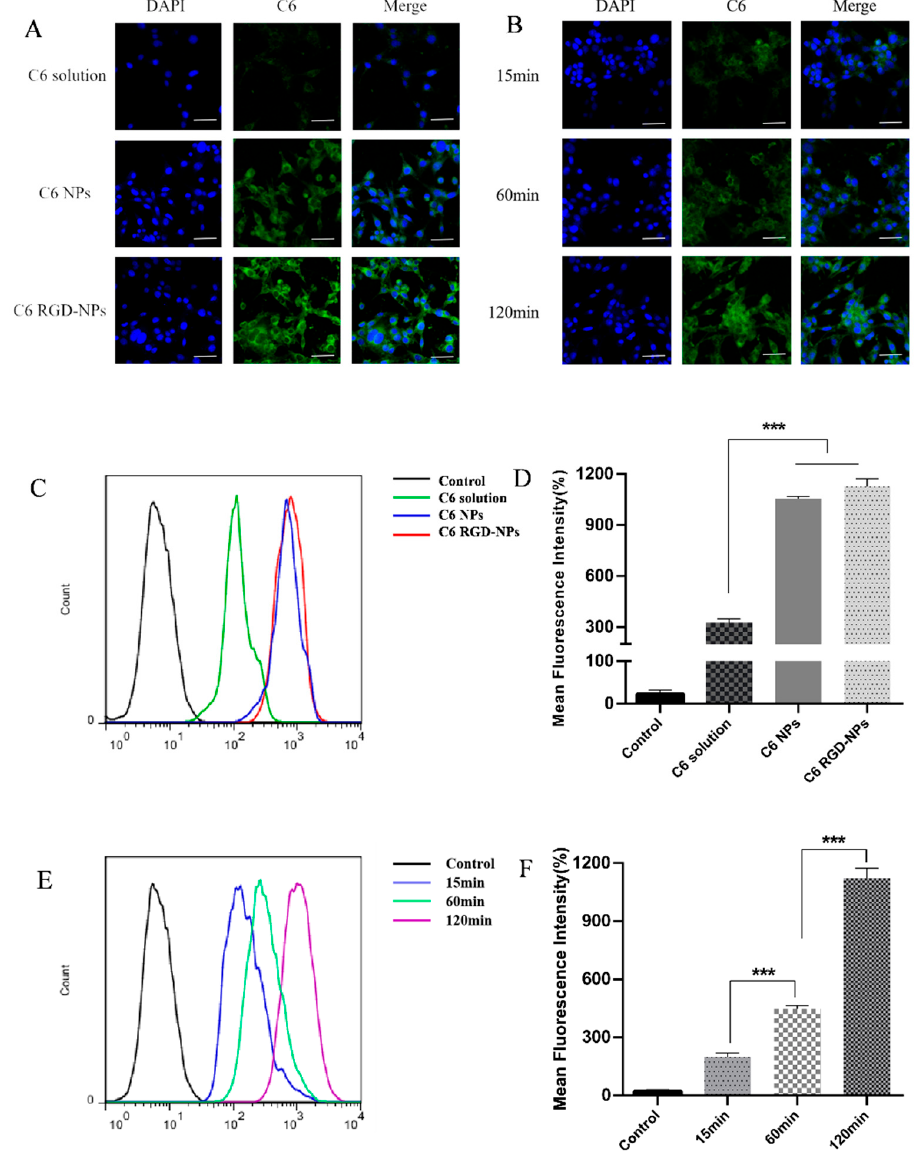
Figure 10. Cell uptake efficiency in vitro. ( A ) Observation of MB49 cells by confocal microscopy after treatment with C6 solution, C6 NPs, and C6 RGD-NPs. Scale bar = 100 µ m. ( B ) Observation of MB49 cells by confocal microscopy after treatment with C6 RGD-NPs for 15, 60, and 120 min., respectively. Scale bar = 100 µ m. ( C , D ) Analysis of the cellular uptake of the control, C6 solution, C6 NPs, and C6 RGD-NPs in MB49 cells by flow cytometry and mean fluorescence intensity. ( E , F ) Analysis of the C6 RGD-NP uptake on MB49 cells for 15, 60, and 120 min by flow cytometry and the mean fluorescence intensity, *** p < 0.001 to